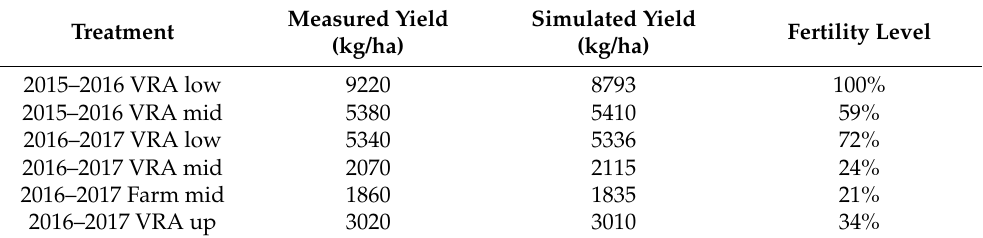
Table 4. Measured and simulated yields and the corresponding fertility level (where a 1 m-soil moisture profile is